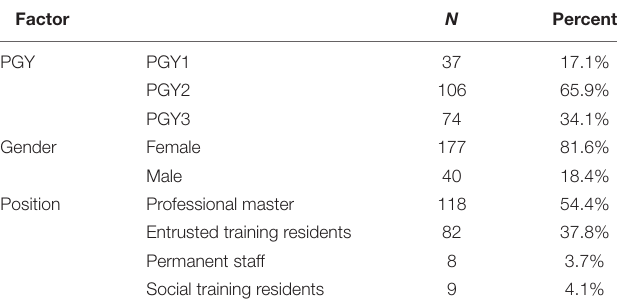
TABLE 5 | Categorical variable information of director-assessment